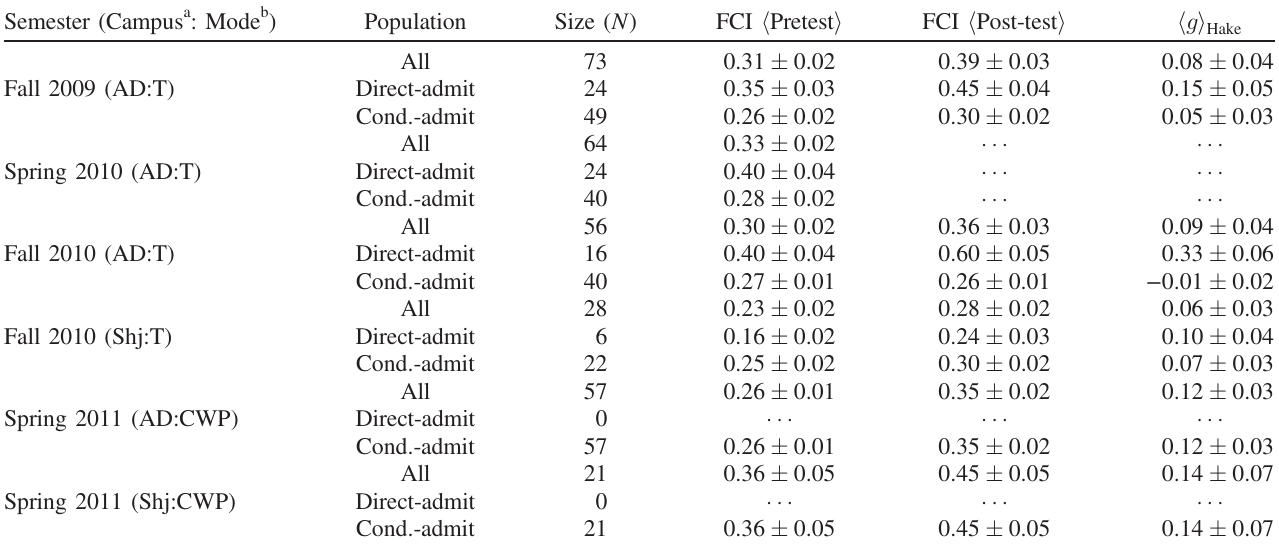
TABLE IV. Force Concept Inventory data spanning Fall 2009 until Spring 2011 semesters for KU ’ s first-semester, calculus-based physics